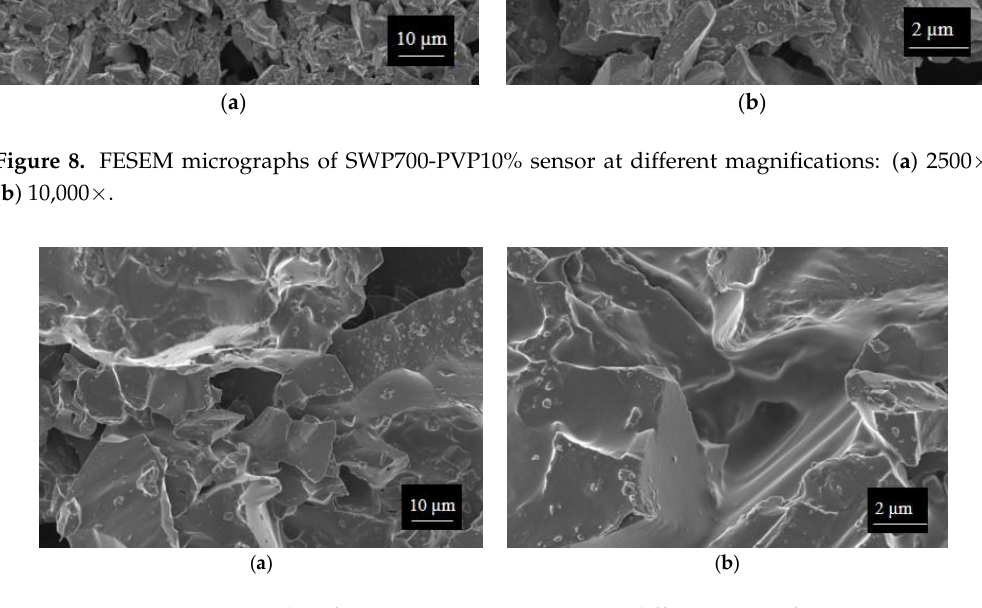
Figure 8. FESEM micrographs of SWP700-PVP10% sensor at different magnifications: ( a ) 2500×; ( b ) 10,000×.